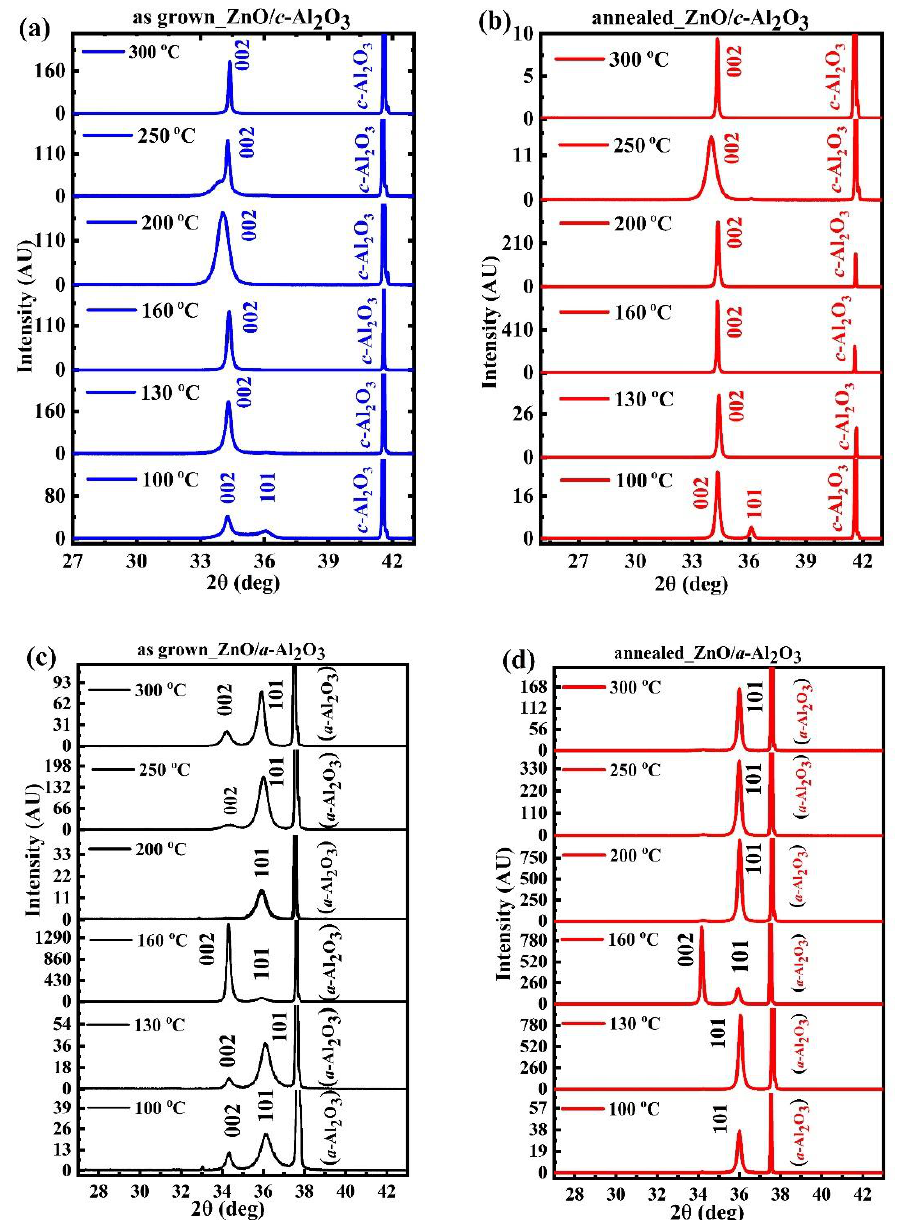
Figure 2. X-ray diffraction patterns of ( a ) as-grown and ( b ) annealed ZnO/ c -Al 2 O 3 films; ( c ) as-grown and ( d ) annealed ZnO/ a -Al 2 O 3 films with successive growth temperature ranges of 100 to 300 ◦ C. Even though films of both types, ZnO/ a -Al 2 O 3 and ZnO/ c -Al 2 O 3 , were grown using the same deposition parameters at six T g (100–300 ◦ C) by the ALD technique, the as grown ZnO/ c -Al 2 O 3 films were mostly (001)-oriented (Figure 2a), whereas as-grown ZnO/ a -Al 2 O 3 films mostly show the semi-polar (101) orientation (Figure 2c). This tendency was even more pronounced for samples subjected to 3-min RTA in O 2 , when all minor peaks disappeared, only those representing a single orientation remained (Figure